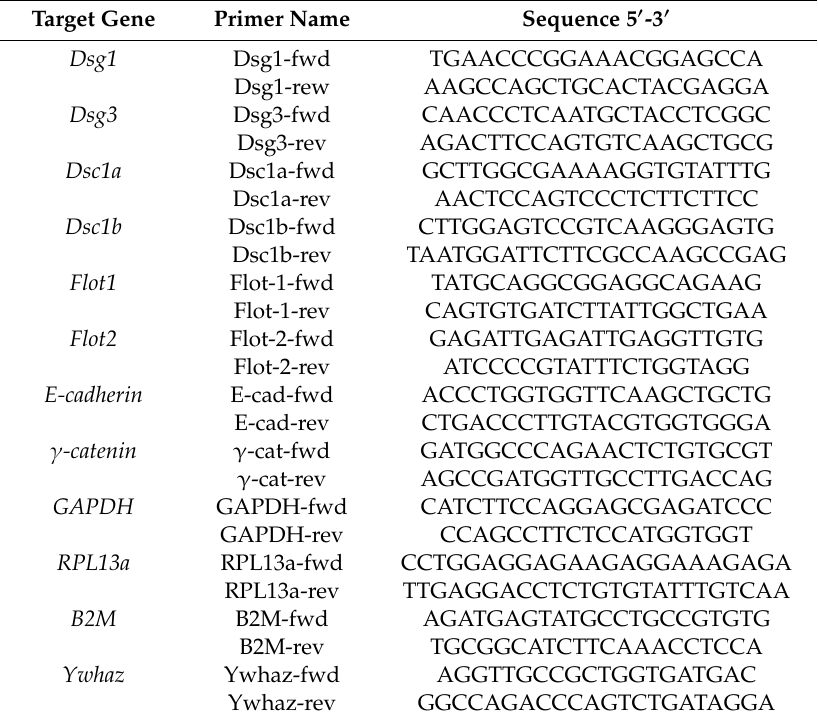
Table 2. The qPCR primers used in this study with their sequences. Target